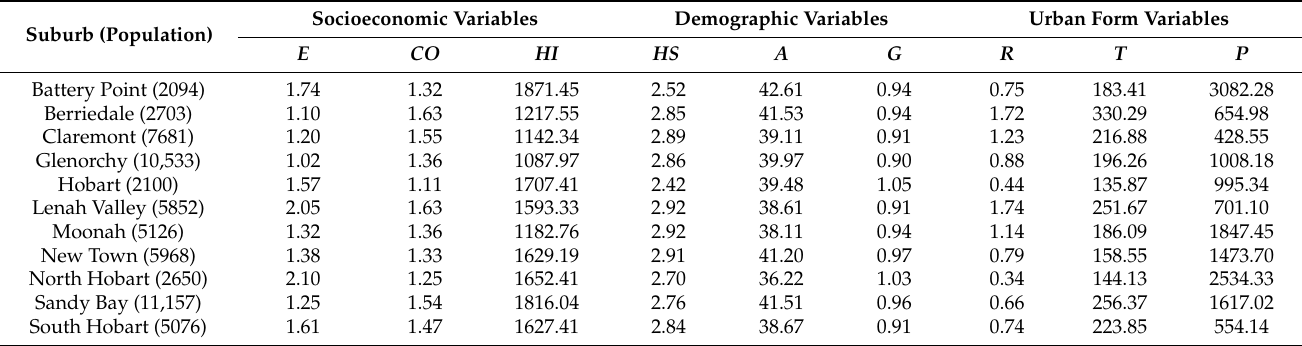
Table 2. Final indicators for independent variable